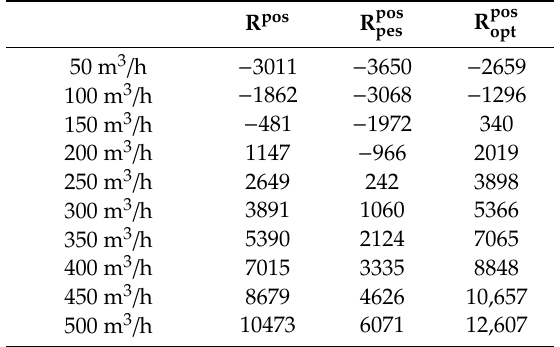
Table 6. Profitability analysis of biomethane plants (thousand € )—point of sale scenarios. R pos R pos